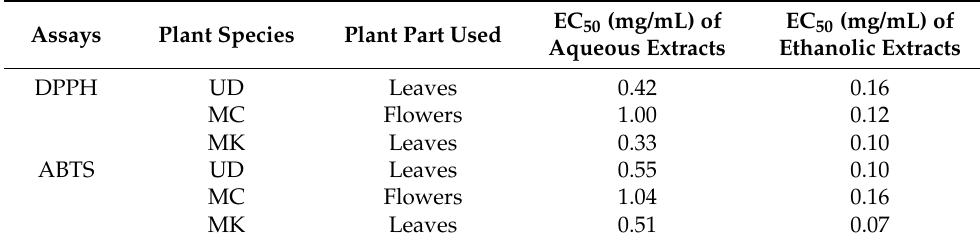
Table 2. Estimated EC 50 (mg/mL) of UD, MC, and MK were obtained by different models using DPPH and ABTS